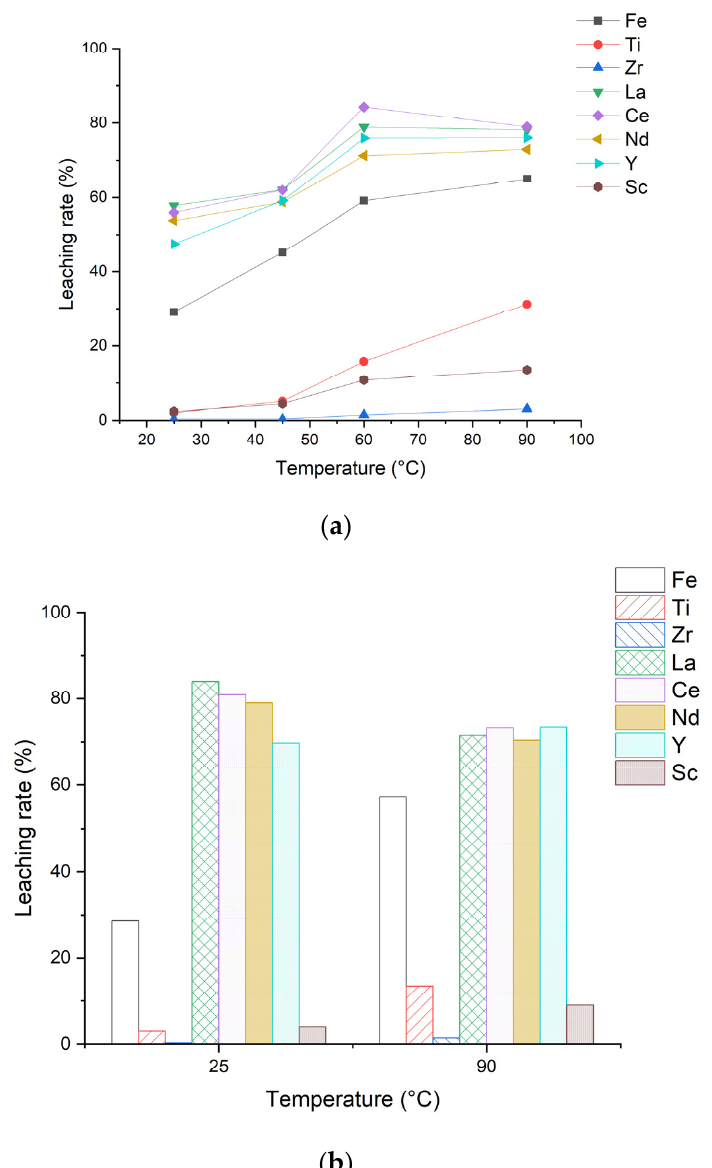
Figure 8. Leaching rate of iron, zirconium, lanthanum, cerium, neodymium, yttrium, and scandium, varying the temperature. Experimental conditions: 100 mL of H 2 SO 4 ( a ) 4.0 mol/L and ( b ) 2 mol/L; 1 v / v % H 2 O 2 ; solid-liquid ratio = 1/10; t = 8 h; under magnetic stirring.